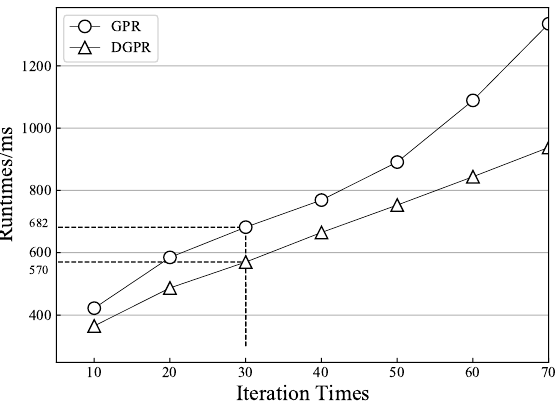
Figure 14. Running time comparison between DGPR algorithm and GPR